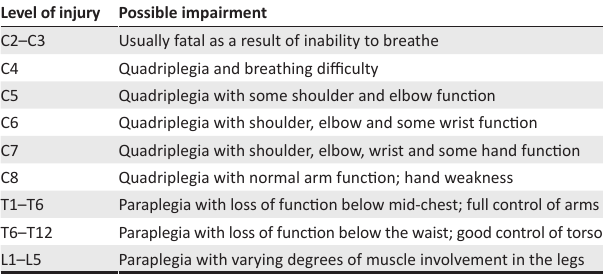
TABLE 1: Spinal cord injuries.